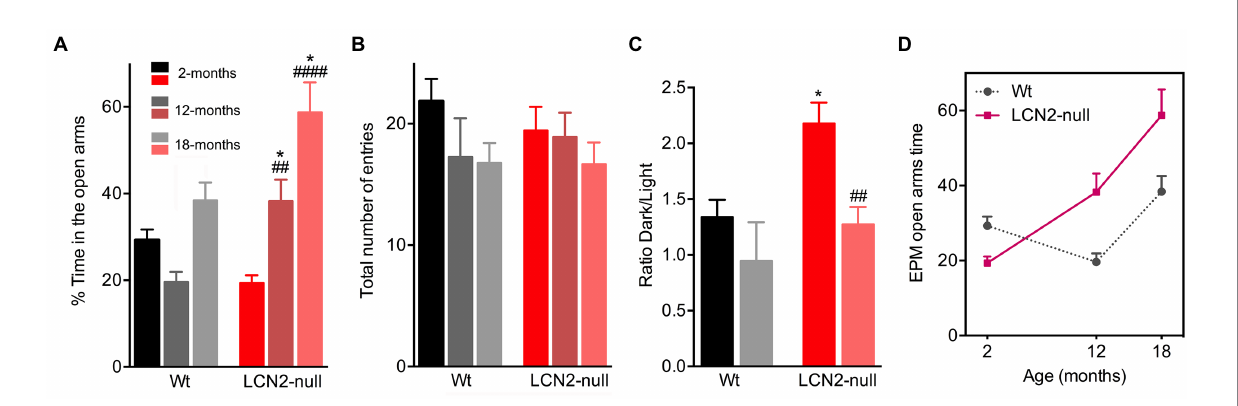
FIGURE 2 Age-related alterations of anxiety-like behaviors in Wt and lipocalin-2 (LCN2)-null mice. (A) Assessment of anxiety-like behavior in the elevated plus maze (EPM) showed an increase in the percentage of time spent in the open arms across age, specifically in LCN2-null mice ( n = 10–12 mice per group). (B) General locomotor activity assessed by the total number of entries in the maze revealed no major aging and genotype effects. (C) In the light/dark box test, anxiety-like behavior of LCN2-null mice at 2-months of old is reduced at 18-months of age. (D) Representative progression of